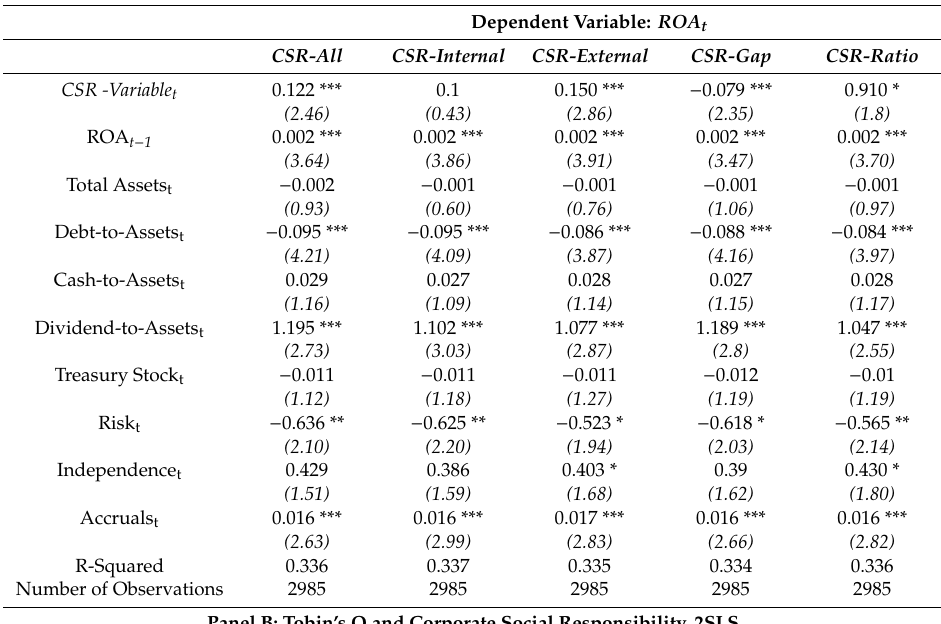
Table 4. 2SLS Analysis of Bank Performance and Corporate Social Responsibility. This table presents the Two-Stage Least Squares results from estimating Equation (1), or the impact that Corporate Social Responsibility has on bank performance. In the first stage, a fitted value of each measure of CSR is calculated using the instrumental variables. In the second stage, Equation (1) is estimated with this fitted value as the measure of the CSR explanatory variable. In Panel A, performance is measured by Return on Assets, or ROA. In Panel B, performance is measured by Tobin’s Q. In the first model, CSR-All is the CSR variable; in the second model, CSR-Internal is the CSR variable; in the third model, CSR-External is the CSR variable; in the fourth model, CSR-Gap is the CSR variable; and in the fifth model, CSR-Ratio is the CSR variable. These variables and all other variables are defined in Appendix A. Standard errors are clustered at the firm level. Intercepts and firm and year fixed e ff ects are included in the model but not tabulated. Coe ffi cients are presented with t-statistics below in parentheses. Statistical significance is indicated with *** for 1%, ** for 5% and * for